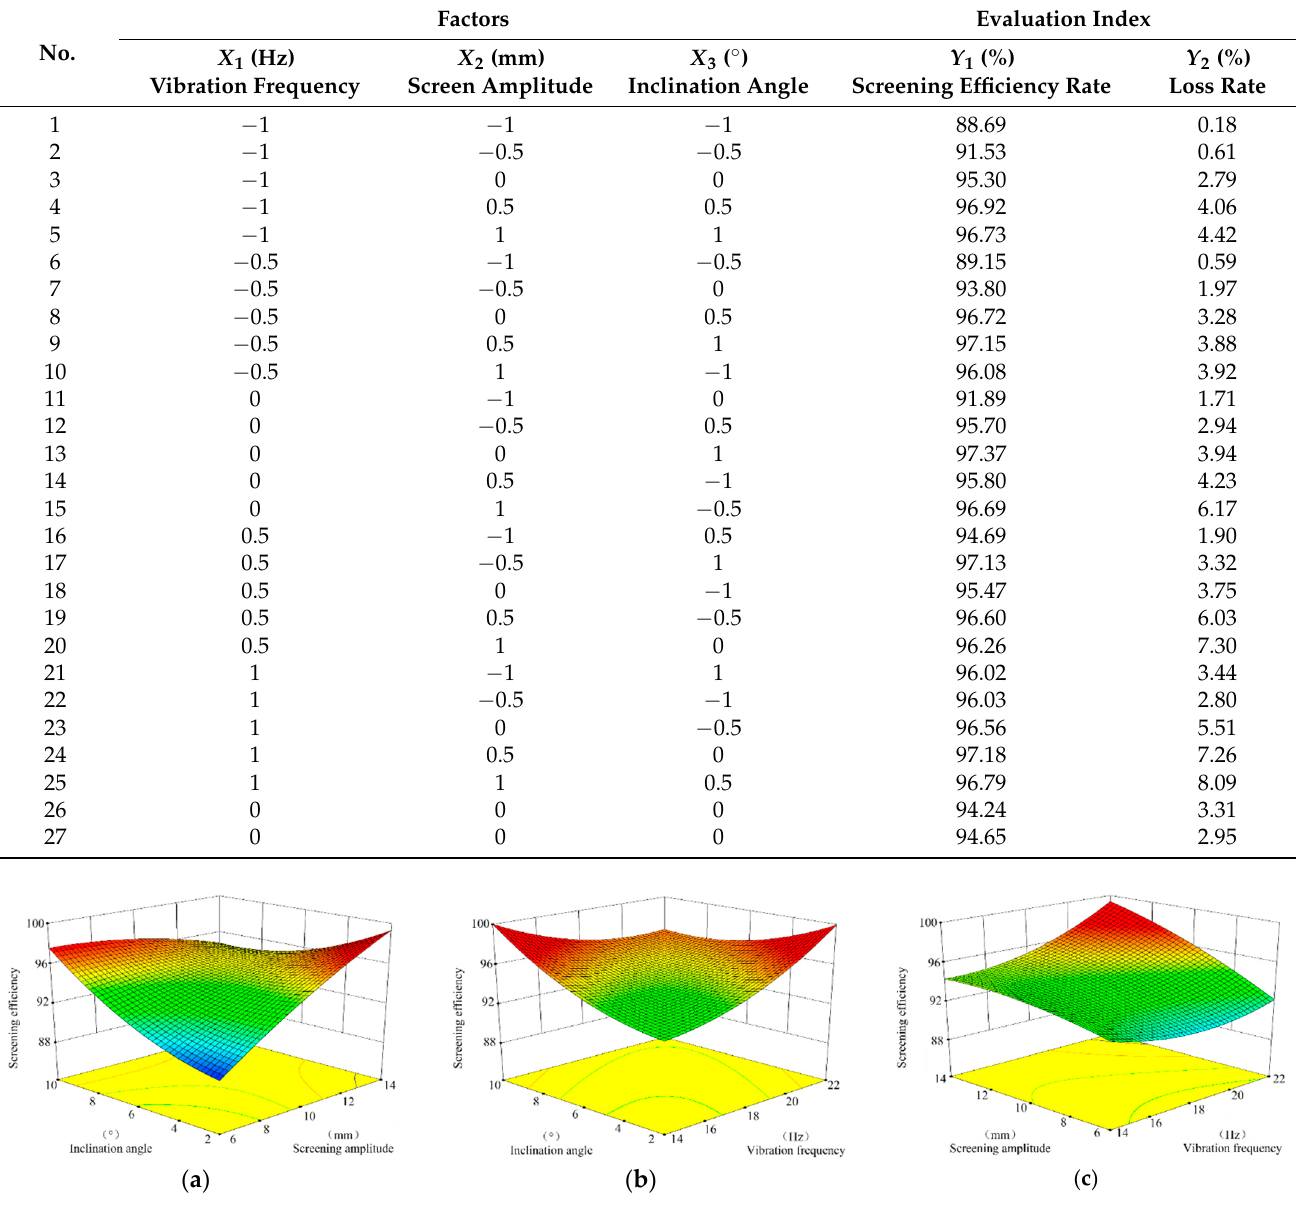
Figure 11. The response surface for the effect of the interaction of the factors on the loss rate. ( a ) Response surface of the effect of SA and IA on screening efficiency; ( b ) Response surface of the effect of VF and IA on screening efficiency; ( c ) Response surface of the effect of VF and SA on screening efficiency.